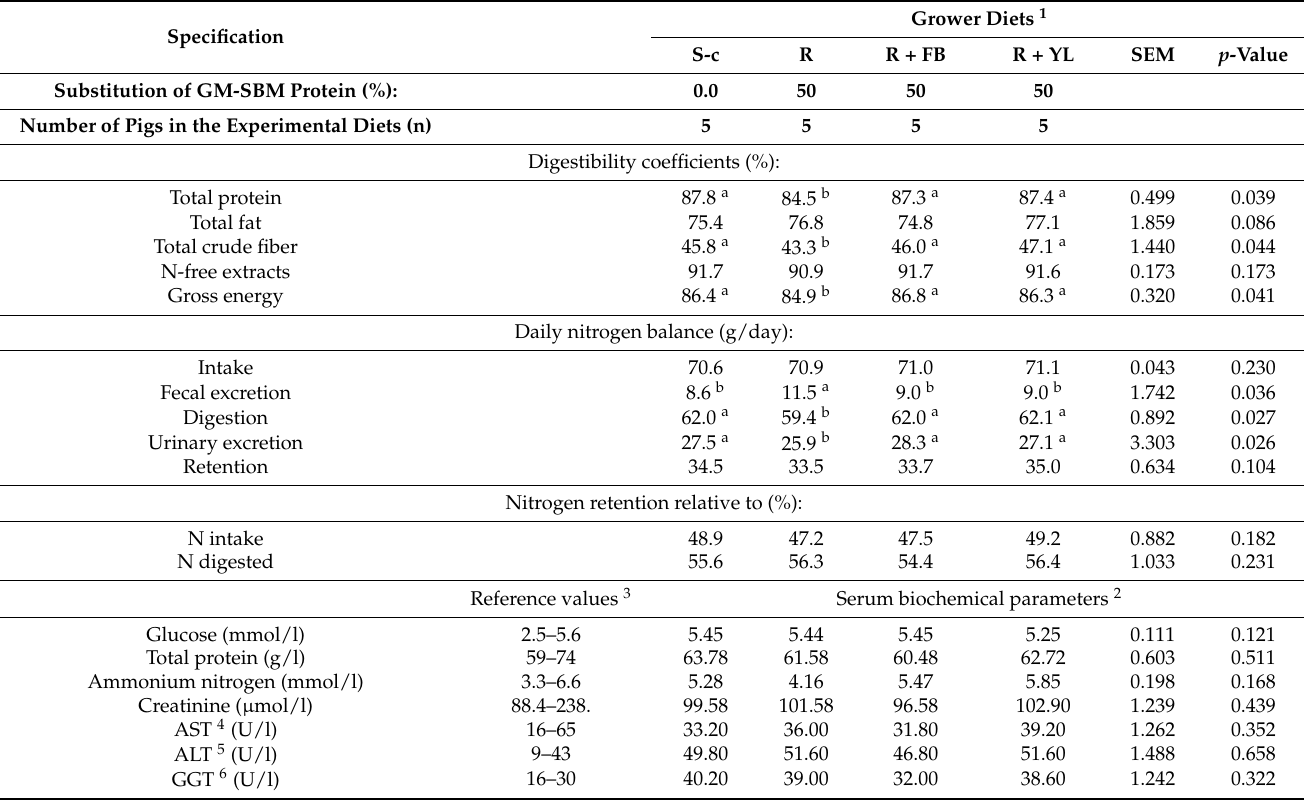
Table 4. Digestibility of nutrients and energy in complete grower diets, nitrogen balance, and serum biochemical parameters of growing pigs ((Experiment I